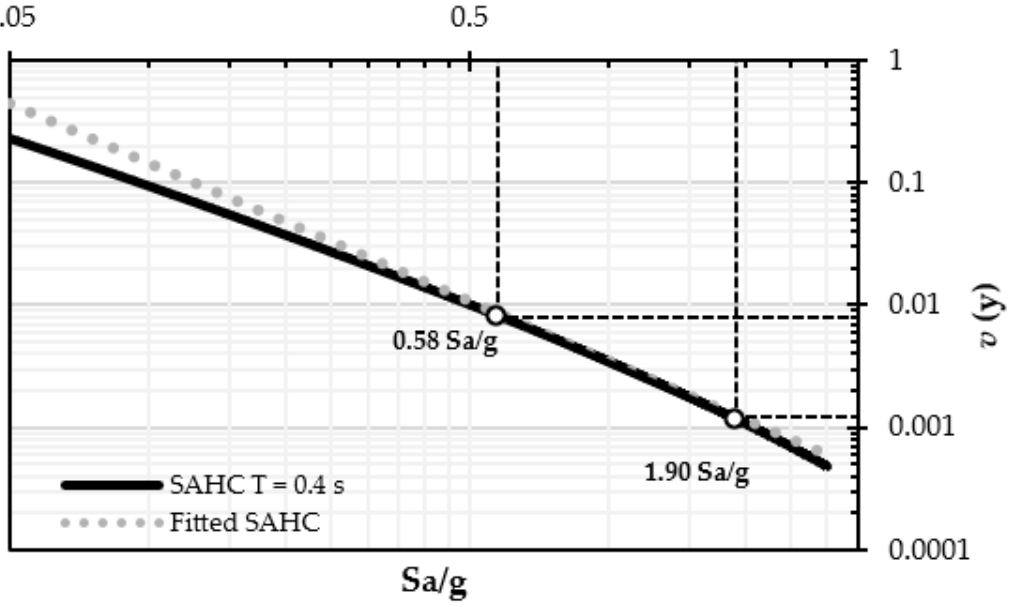
Figure 7. Spectral acceleration hazard curve for the fundamental period, T = 0.40